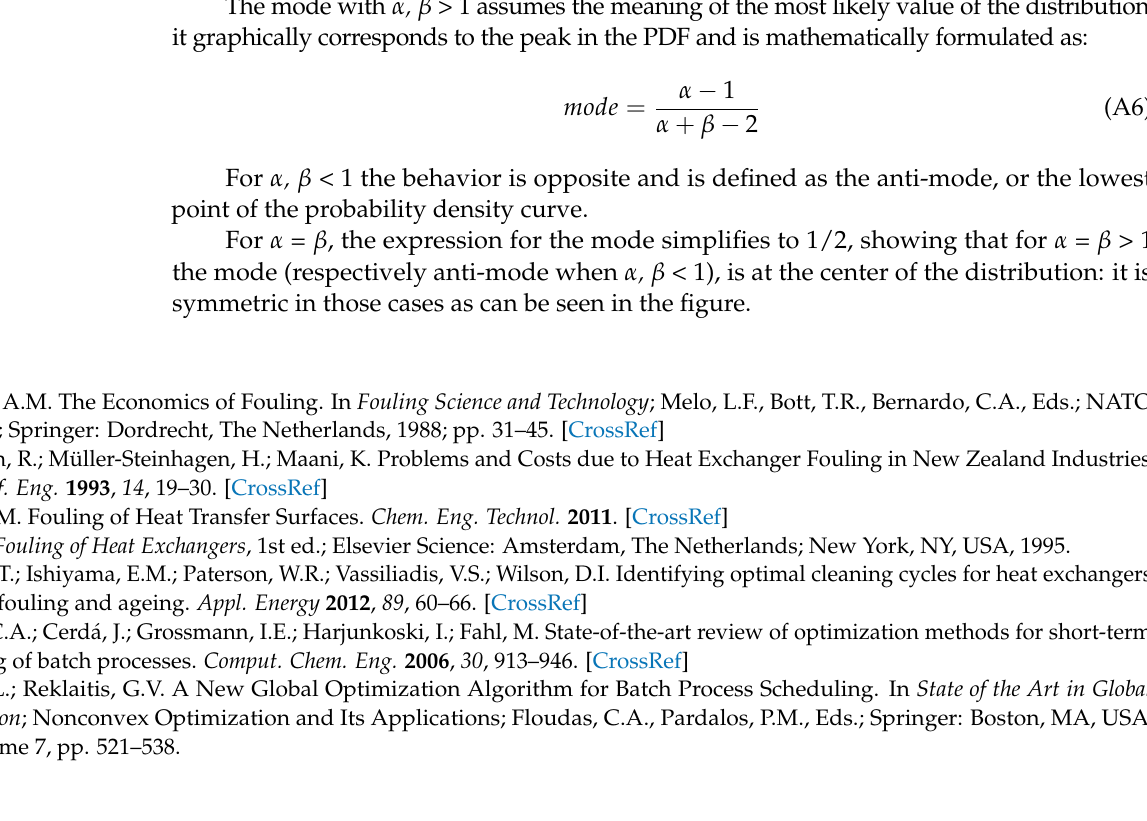
The mode with α , β > 1 assumes the meaning of the most likely value of the distribution, it graphically corresponds to the peak in the PDF and is mathematically formulated as: